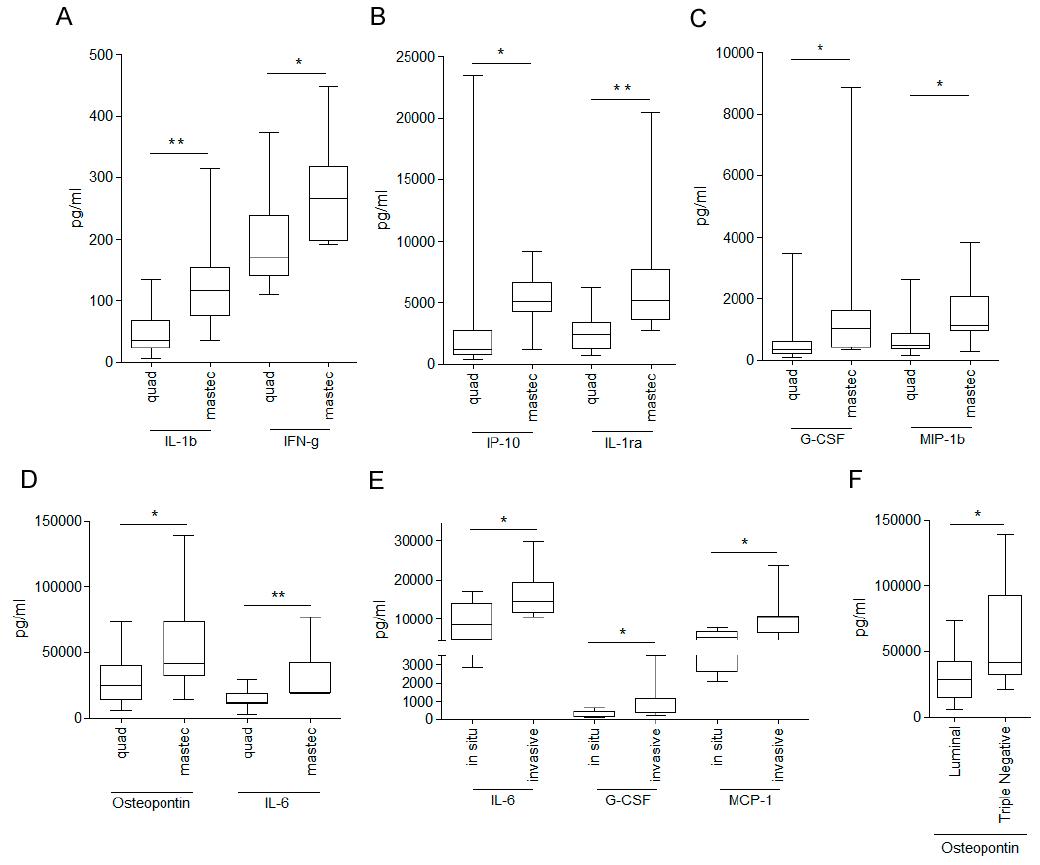
Differences in small-molecule composition of wound healing fluid from breast carcinoma surgery according to type of surgery, tumor histology, and tumor molecular subtype. Concentration (pg/mL) of 34 molecules, including cytokines, chemokines, and growth factors (listed in Material and Methods), was assessed by Bio-plex assay in 27 wound healing fluids from breast cancer patients. Levels of small molecules were differentially enriched by surgery ( A – D ), tumor histology ( E ), and tumor molecular subtype ( F ) (* p -value ≤ 0.05; ** p -value ≤ 0.01; Mann–Whitney test).